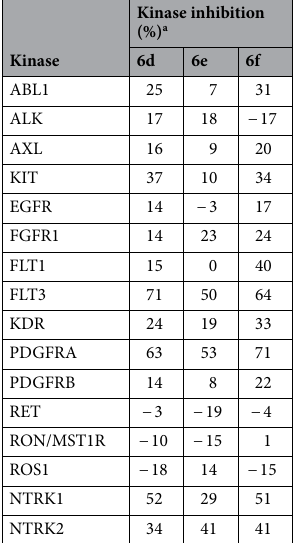
Table 3. Measurement of the inhibitory effects of synthesized derivatives 6d , 6e and 6f against a panel of different tyrosine kinases. a Percent inhibition was measured at the concentration of 25